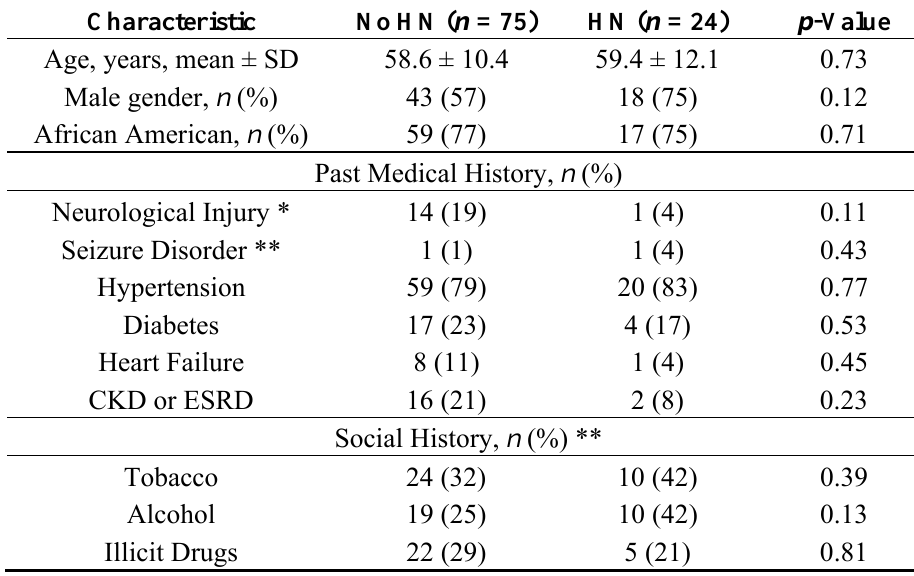
Table 1. Baseline Patient Characteristics: CKD, chronic kidney disease; ESRD, end stage renal disease; NSAIDs, nonsteroidal anti-inflammatory drugs; COX, cyclooxygenase; SSRI, selective serotonin reuptake inhibitor; GCS, Glasgow Coma Scale; ICH, intracerebral hemorrhage; HN,